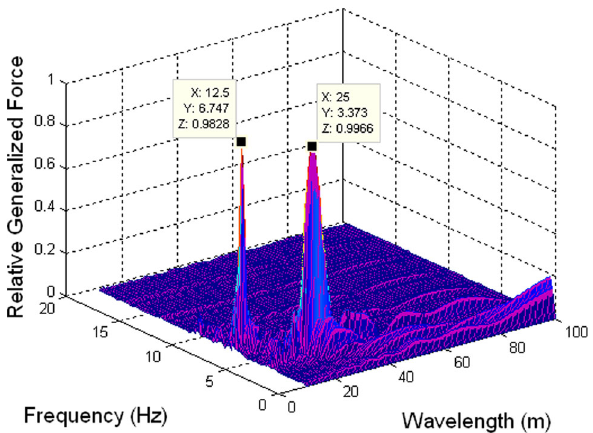
Fig. 8 Spectra of relative generalized forces against various assumed wavelengths of the